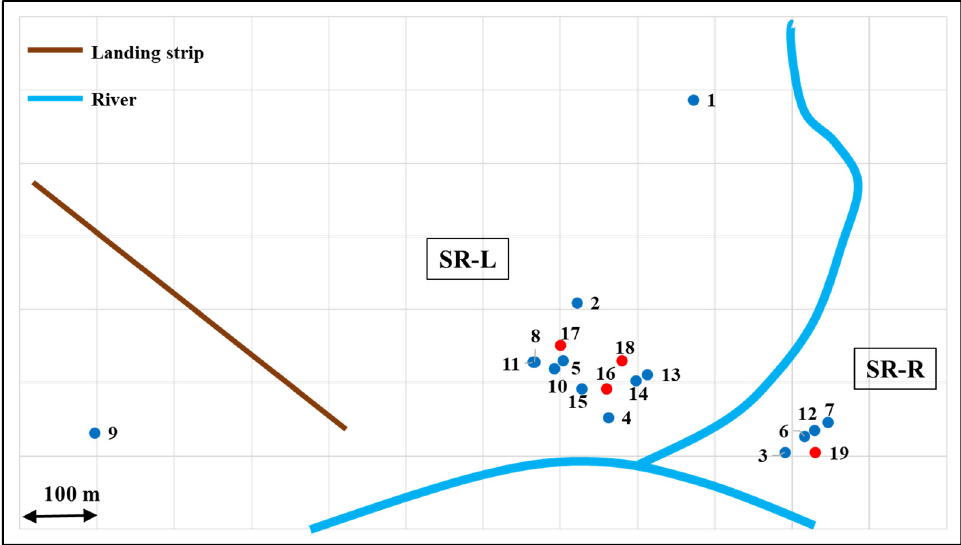
Figure 5. Demand and potential generation points in Santa Rosa. Numbers refer to the households (blue) and potential generation points (red).